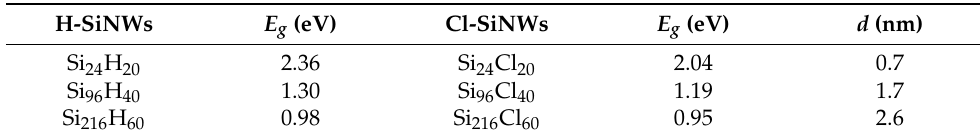
Table 2. Energy band gap of fully passivated Cl- and H-functionalized <112> oriented SiNWs with different diameters.